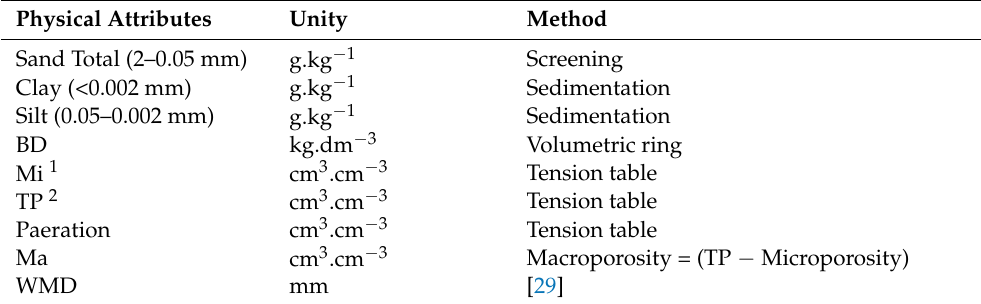
Table 2. Physical characteristics of soils with their respective methods and standards.